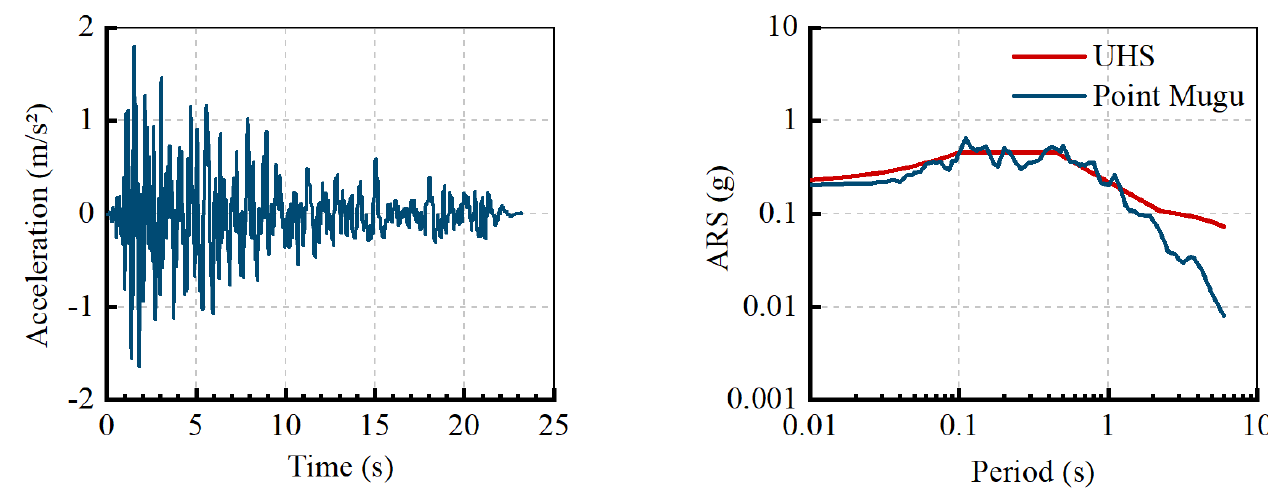
Figure 6. Input ground motion acceleration time history and response spectrum.